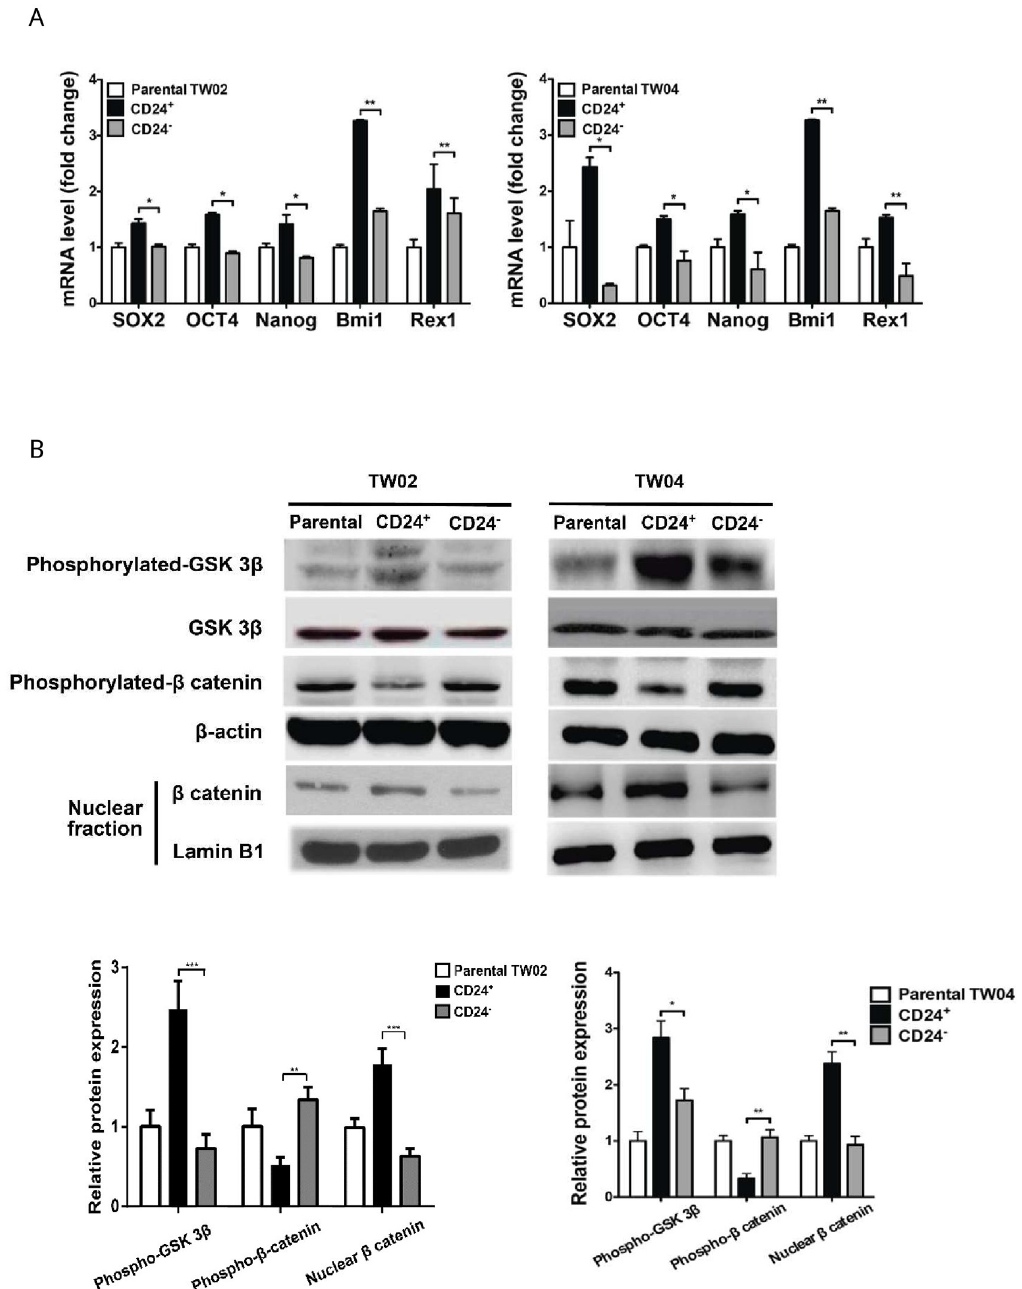
Fig 2. Expression levels of stem cell genes and activation of the Wnt/ β -catenin pathway in CD24+ cells. (A) mRNA expression of Sox2 , Oct4 , Nanog , Bmi-1 and Rex-1 in parental, CD24+ and CD24 − cells from the NPC cell lines, TW02 (left) and TW04 (right), was evaluated using quantitative RT-PCR analysis. The results shown represented averages of three independent experiments. � : p < 0.05, �� : p < 0.01. (B) Western blot analysis of phosphorylated-GSK 3 β , GSK 3 β , phosphorylated- β -catenin and β -actin in whole cell lysates, and of β -catenin and lamin B1 in nuclear fractions of parental, CD24+, and CD24 − cells isolated from the TW02 and TW04 cell lines. Quantitative results were calculated using the ImageJ software. The TW02 nuclear fractions correspond to the results of a replication experiment performed after the other experiments reported in the original figure. New samples were generated for this replication experiment, but the same methodology reported in the original article was used. The results represent means ± SD of three independent trials. Protein expression levels for phosphorylated-GSK 3 β , phosphorylated- β catenin and nuclear β catenin were normalized against non-phosphorylated GSK 3 β , β -actin and nuclear lamin B1, respectively. � : p < 0.05, �� : p < 0.01, ��� : p <